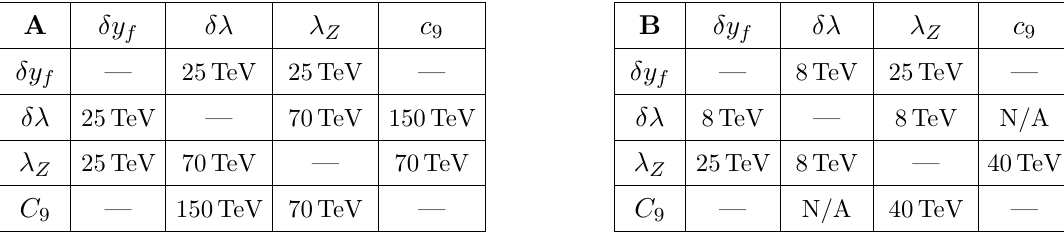
Table 4 . Estimate of ballpark for maximal mass M detectable, for each pair of pseudo-observables, considering ILC projections, see text for